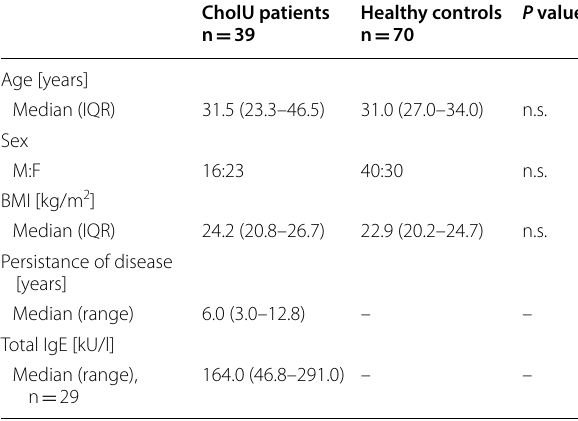
Table 1 Clinical characteristics of study